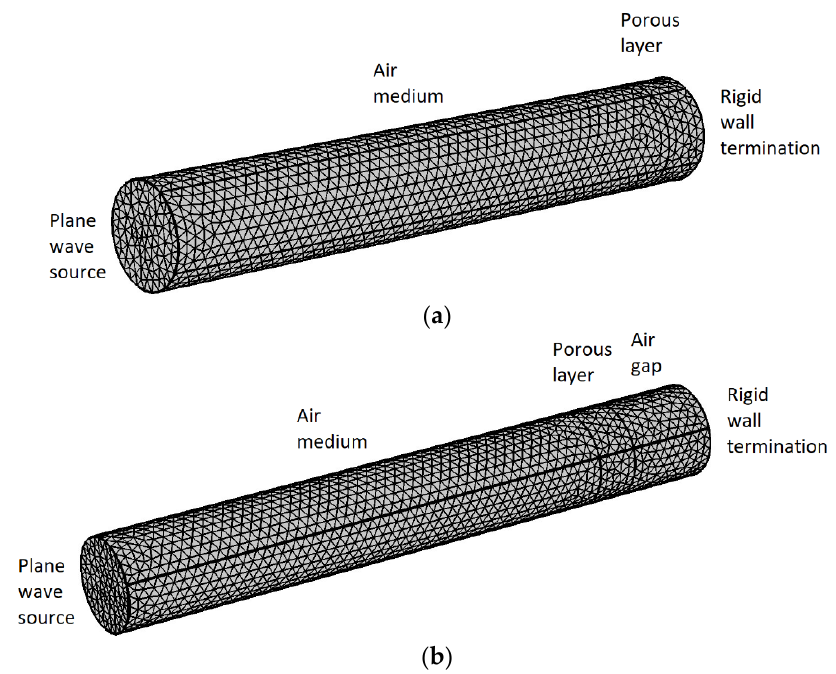
Figure 5. 3D FEM model—discretization: ( a ) Impedance tube with porous layer backed with rigid wall; ( b ) Impedance tube with air gap between the porous layer and the rigid wall termination.